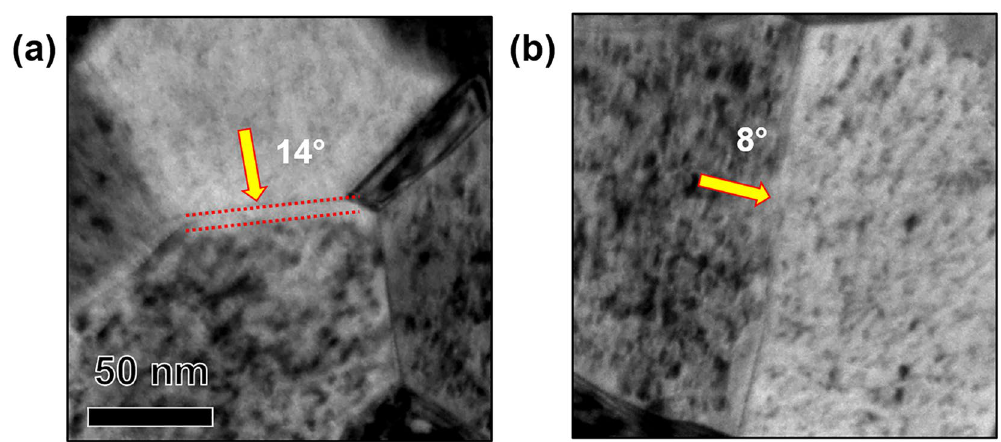
Figure 8. Bright-field TEM images of ( a ) loop denuded and ( b ) non-denuded LAGB of irradiated nanocrystalline Fe at the end dose (2.87 × 10 21 ion.m − 2 ). Misorientation angles are labelled in the